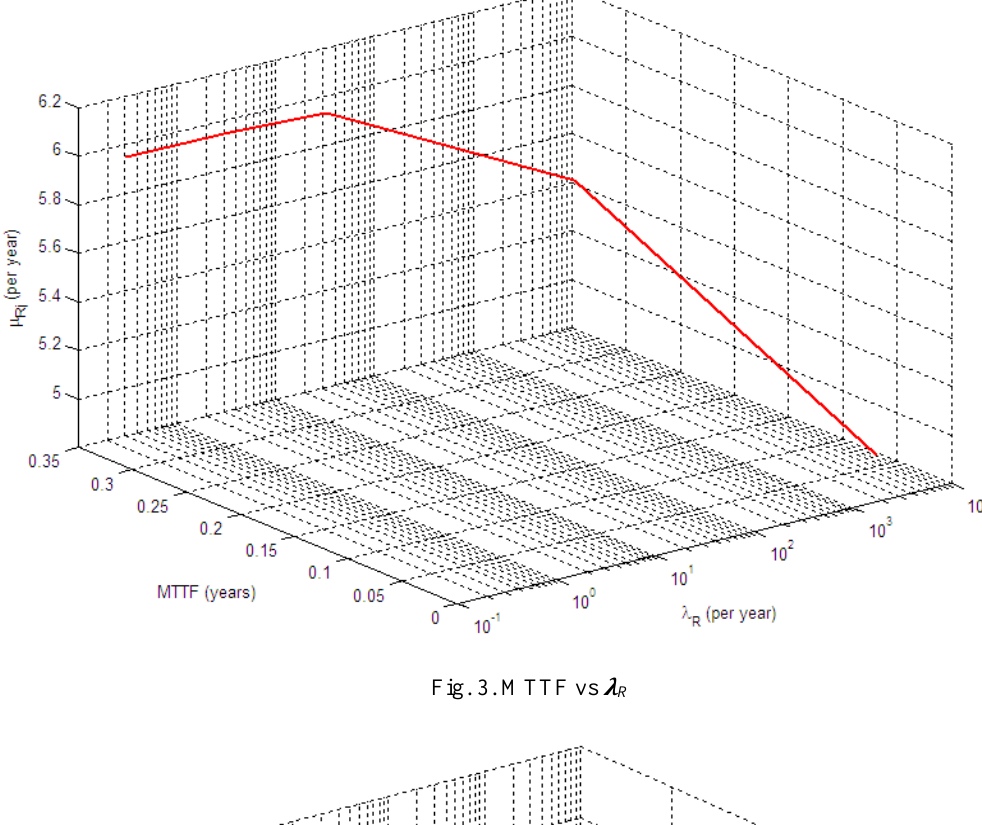
Fig. 3. MTTF vs 𝛌 R